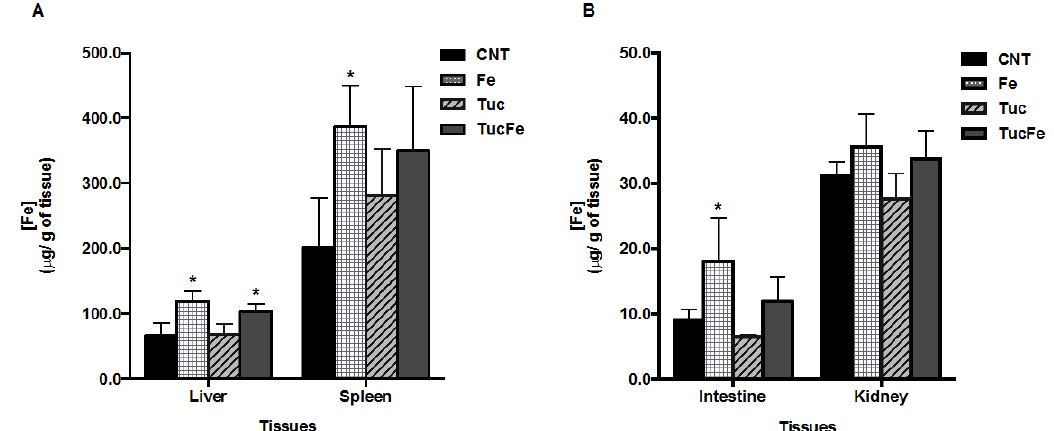
Figure 1. Iron levels in tissues, according to group treatment. CNT, Control group; Fe, iron-enriched group, Tuc, tucum-do-cerrado group; TucFe, tucum-do-cerrado iron-enriched group. Data are the means ± SD ( n = 6). Significant differences ( p < 0.05): * Comparison to the Control group.